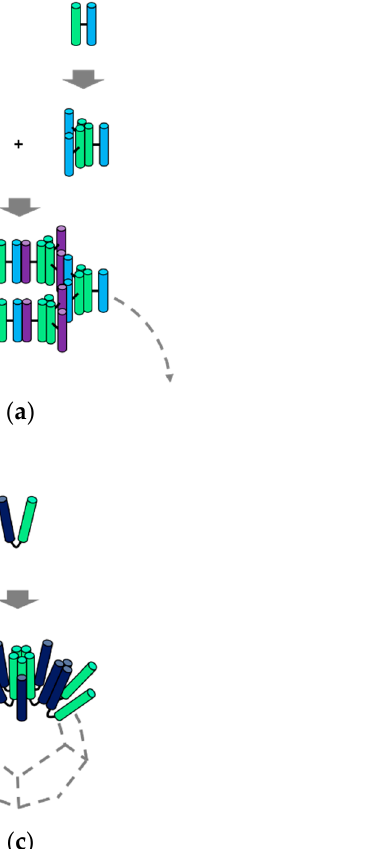
Figure 4. Self-assembly of discrete nanoparticles. ( a ) self-assembled cage-like particles (SAGEs) [35] and ( b ) vesicles [38] are the hollow spheres into which curved lamellar of laterally assembled coiled-coil building blocks are closed; ( c ) a dodecahedron built from the self-assembling peptide nanoparticle (SAPN) system [36] and ( d ) octahedron designed by fusion of coiled-coils to symmetric oligomeric protein folds [37]. These polyhedral nanoparticles are formed by the symmetry-directed assembly.